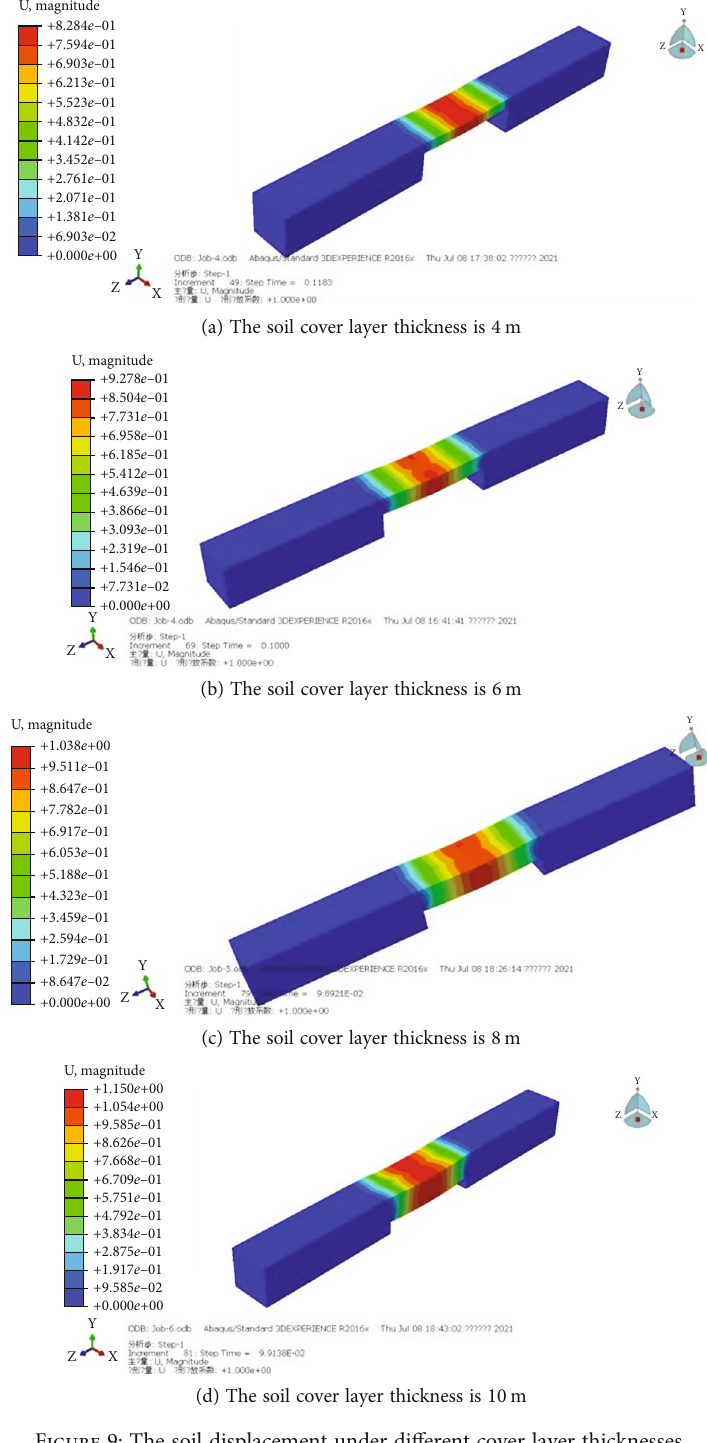
Figure 9: The soil displacement under di ff erent cover layer